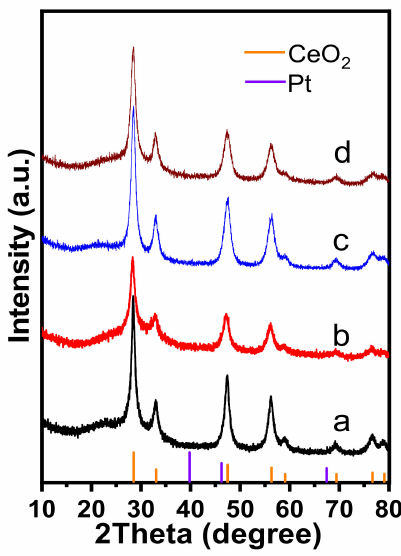
Figure 1. XRD patterns of (a) CeO 2 -NS before calcination; (b) Pt/CeO 2 -NS before calcination; (c) CeO 2 -NS and (d) Pt/CeO 2